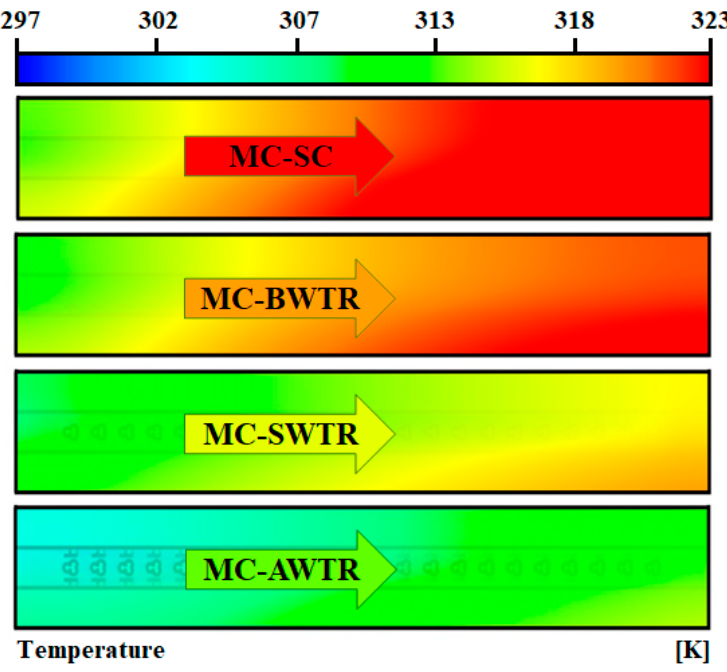
Figure 3. Temperature distribution of MCHS with trefoil shaped ribs attached to different walls.